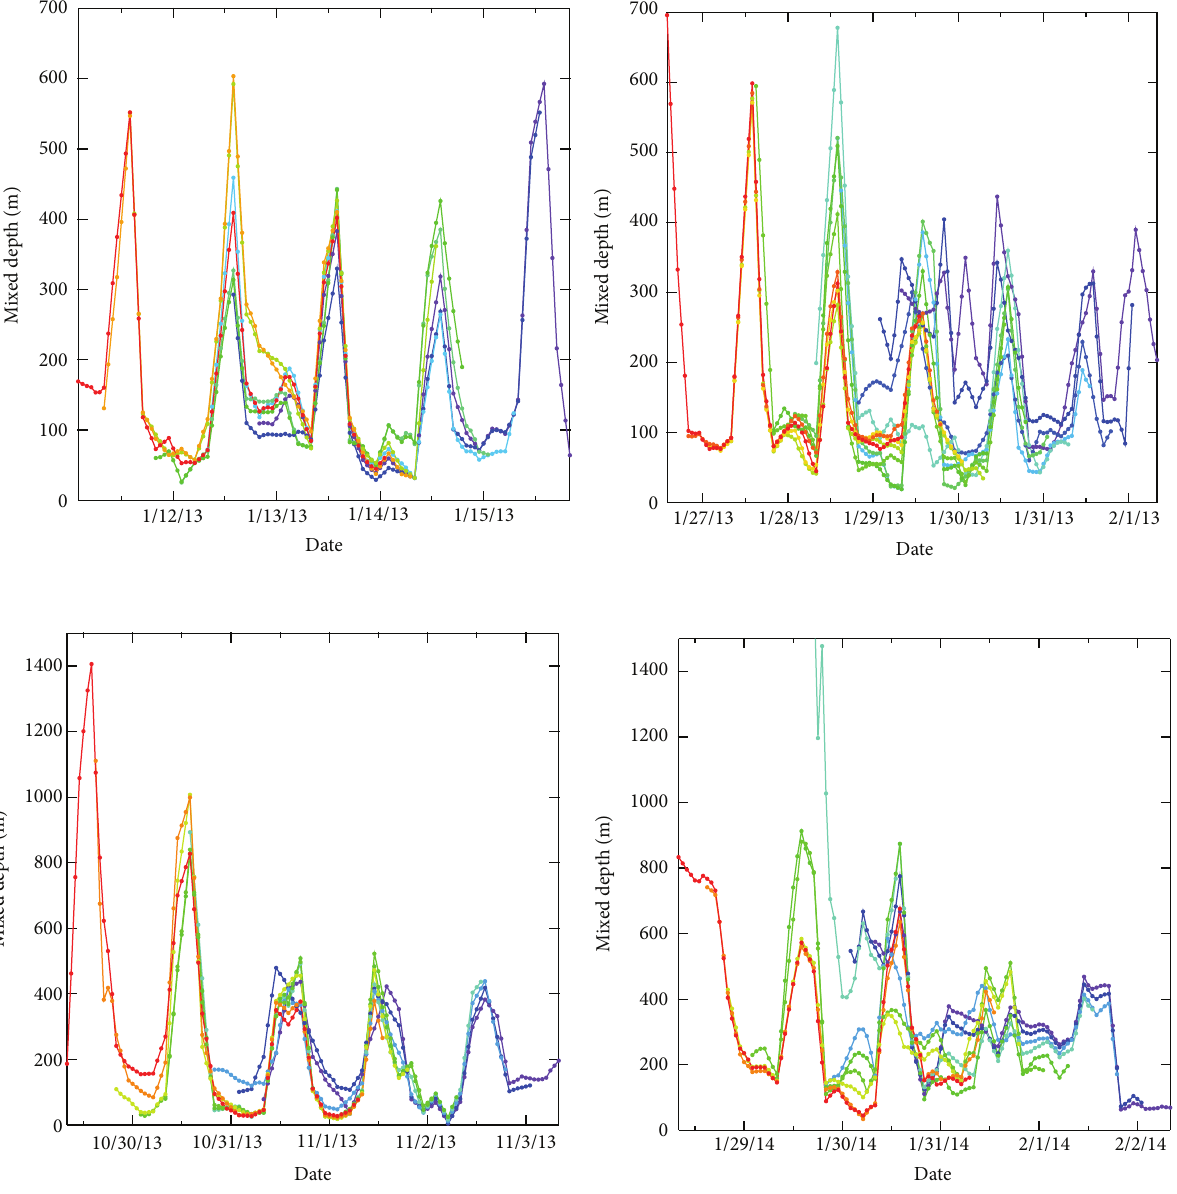
Figure 5: Changes in mixed layer depth along the air-mass back trajectories for the four fog events occurring in Ji’nan during the period from March 2012 to February